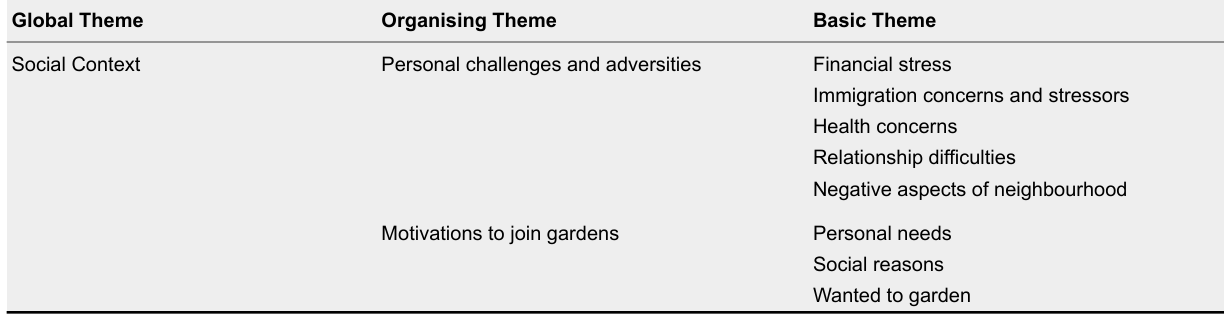
Coding Framework for Social Context